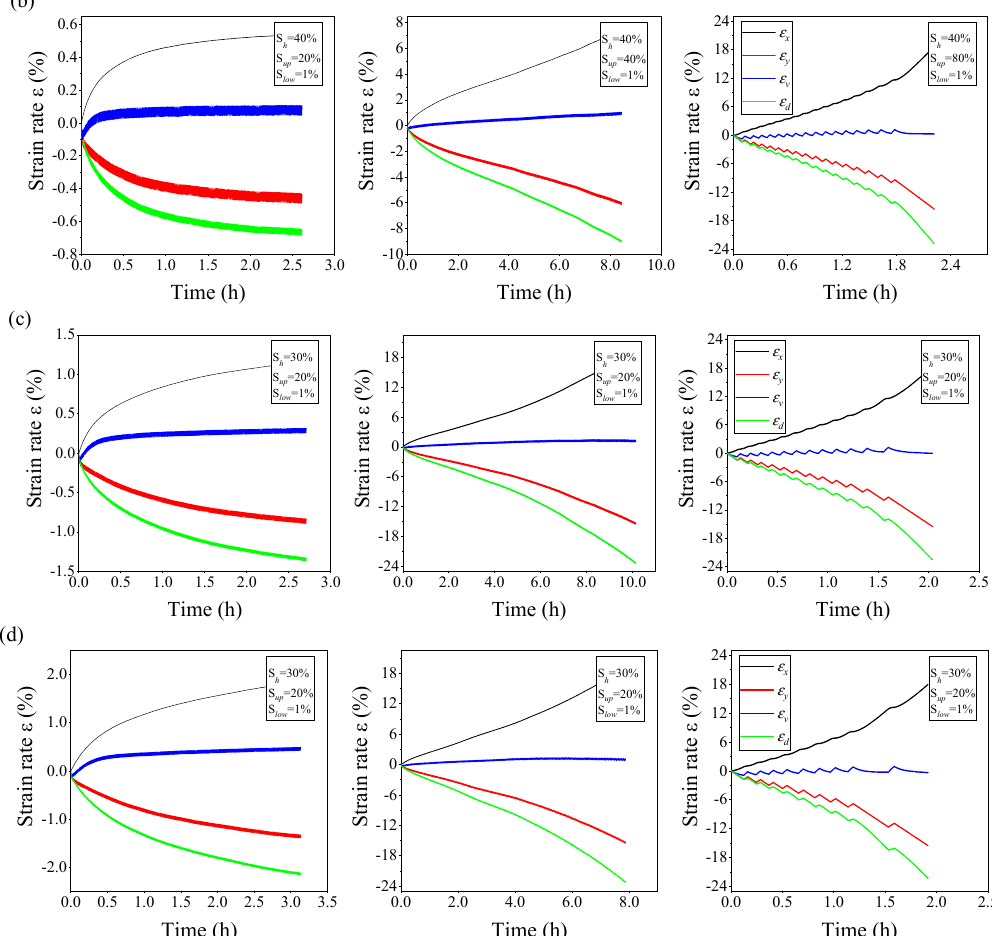
Figure 11. The effect of the dynamic stress amplitude on the strain of the MHS with different S h values. Figure 11. The e ff ect of the dynamic stress amplitude on the strain of the MHS with di ff erent S h values. (a) S h = 30%; (b) S h = 40%; (c) S h = 50%; (d) S h = 65%. ( a ) S h = 30%; ( b ) S h = 40%; ( c ) S h = 50%; ( d ) S h =